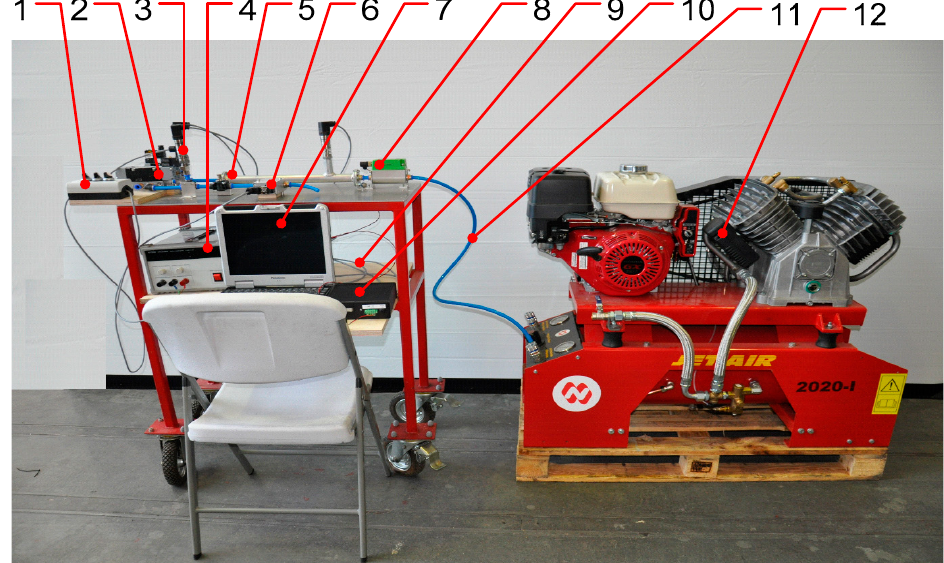
Figure 5. Stand for testing flow parameters of pneumatic elements: 1—control panel, 2—tested manifold, 3—pressure sensor, 4—laboratory power supply, 5—measuring pipe, 6—cut-off valve, 7—computer, 8—flowmeter, 9—signal and power cables, 10—control panel, 11—pneumatic tube, 12—compressor.